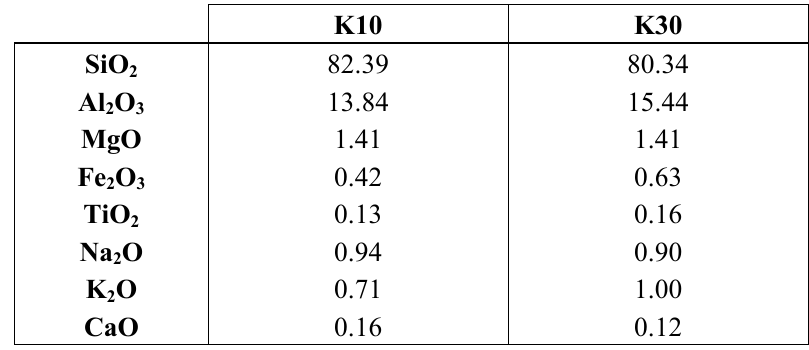
Table 1. Chemical analysis (%) of commercial acid treated MMT clays.